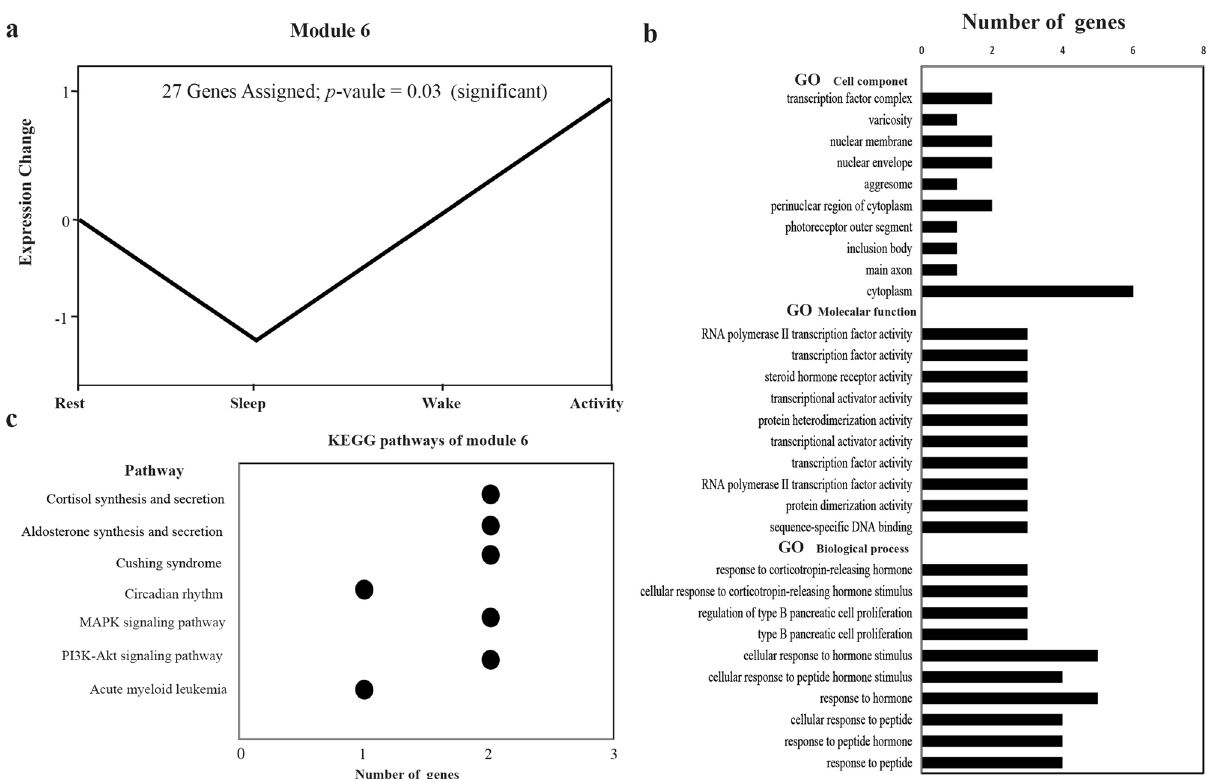
Figure 4. The trend of module 6 and the associated enrichment results. ( a ) The trend of genes in module 6 at four time points. ( b )Top 10 GO categories with the most significant p values that were significantly enriched for genes from module 6. ( c ) KEGG pathways significantly enriched for genes from module